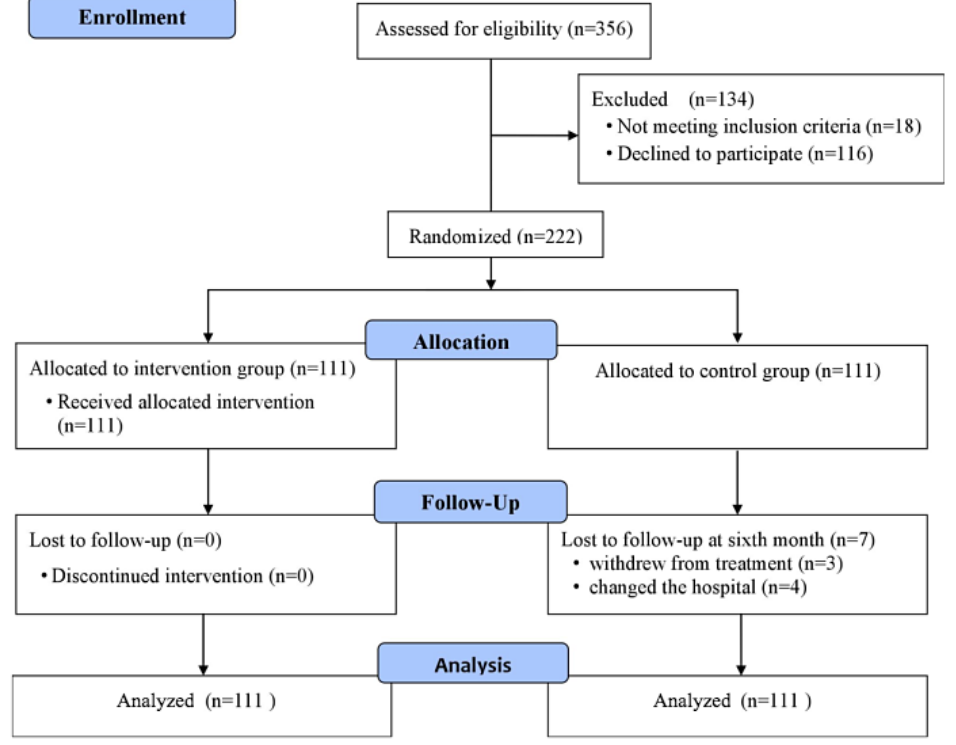
Figure 4. Flow diagram of the inclusion of patients in the randomized trial of the two groups.